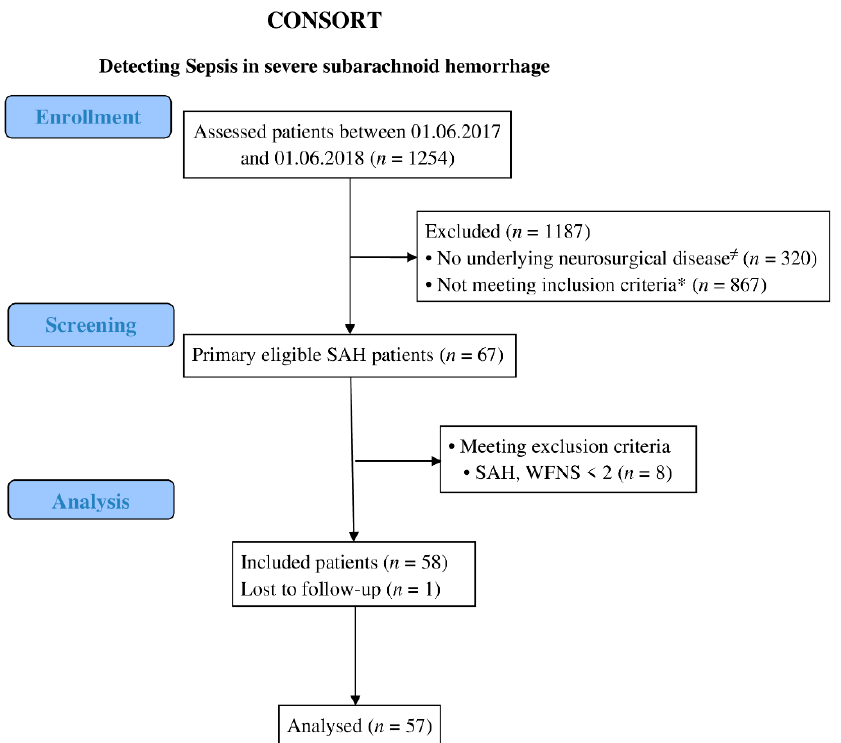
Figure 1. Consolidated Standards of Reporting Trials (CONSORT) diagram of patients included in the study. Diagram of the inclusion process and the reasons for exclusion. Abbreviations: SAH, sub- arachnoid hemorrhage; WFNS, World Federation of Neurosurgery clinical severity of subarachnoid hemorrhage. ≠ Intensive care admission due to primary neurological disorders * Intensive care unit admission due to neurosurgical diagnosis in the without presence of subarachnoid hemorrhage. Table 1. Clinical characteristics according to the septic episodes.